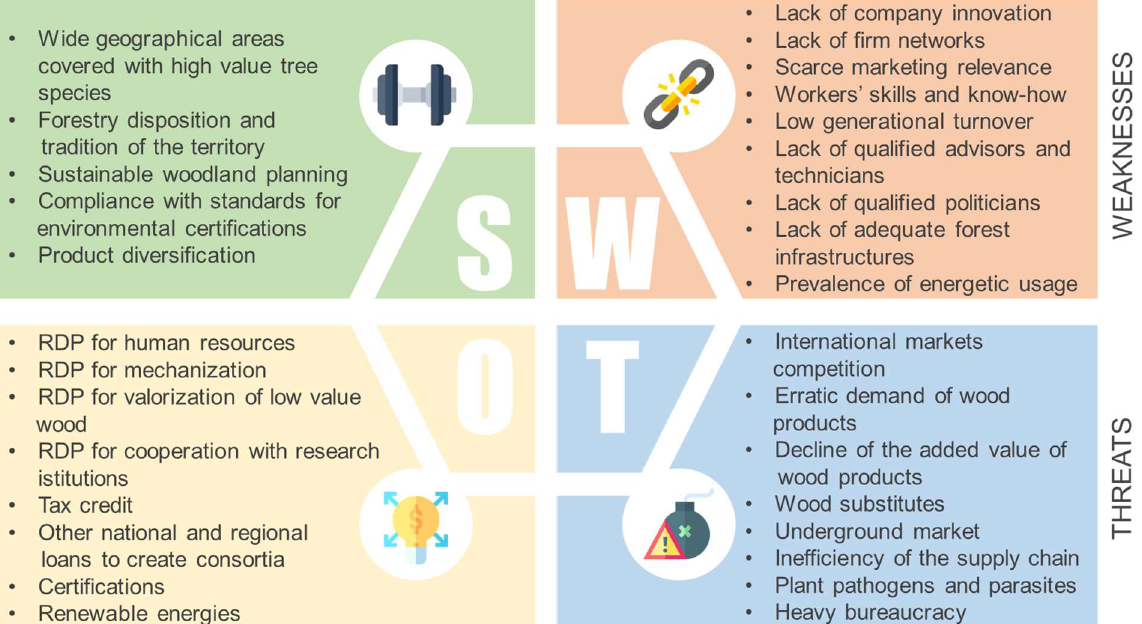
Figure 5. Summary of the SWOT analysis. Notes: RDP = Regional Development Plan; Icons are courtesy of Freepik: https://www.flaticon.com/authors/freepik (accessed 10 November 2022).